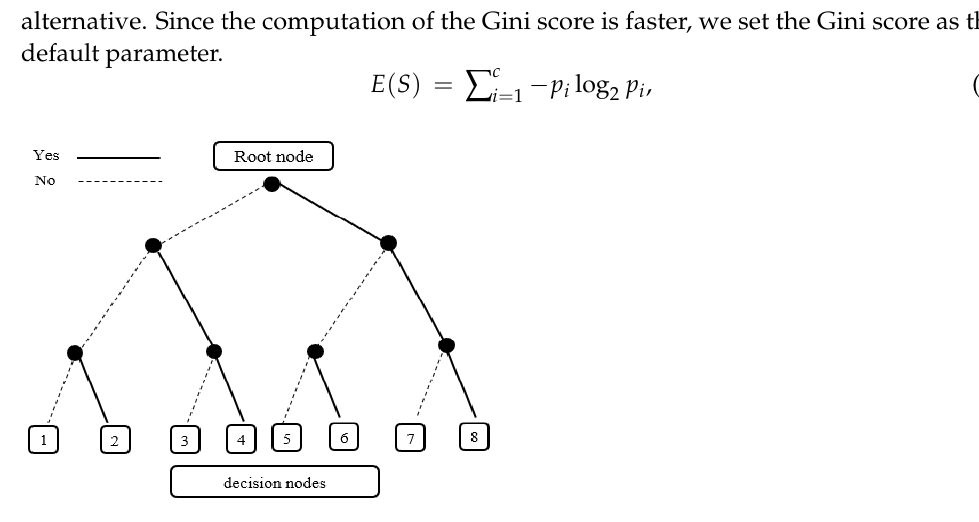
Figure 1. The decision Tree example.